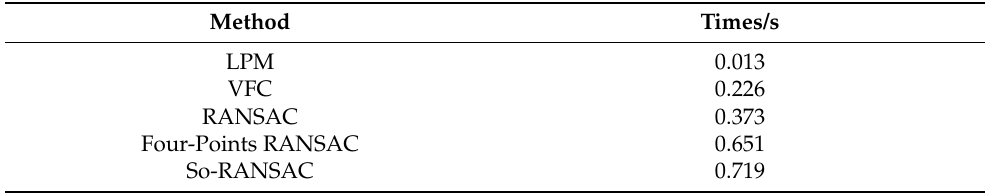
Table 6. Comparison of the reprojection error.